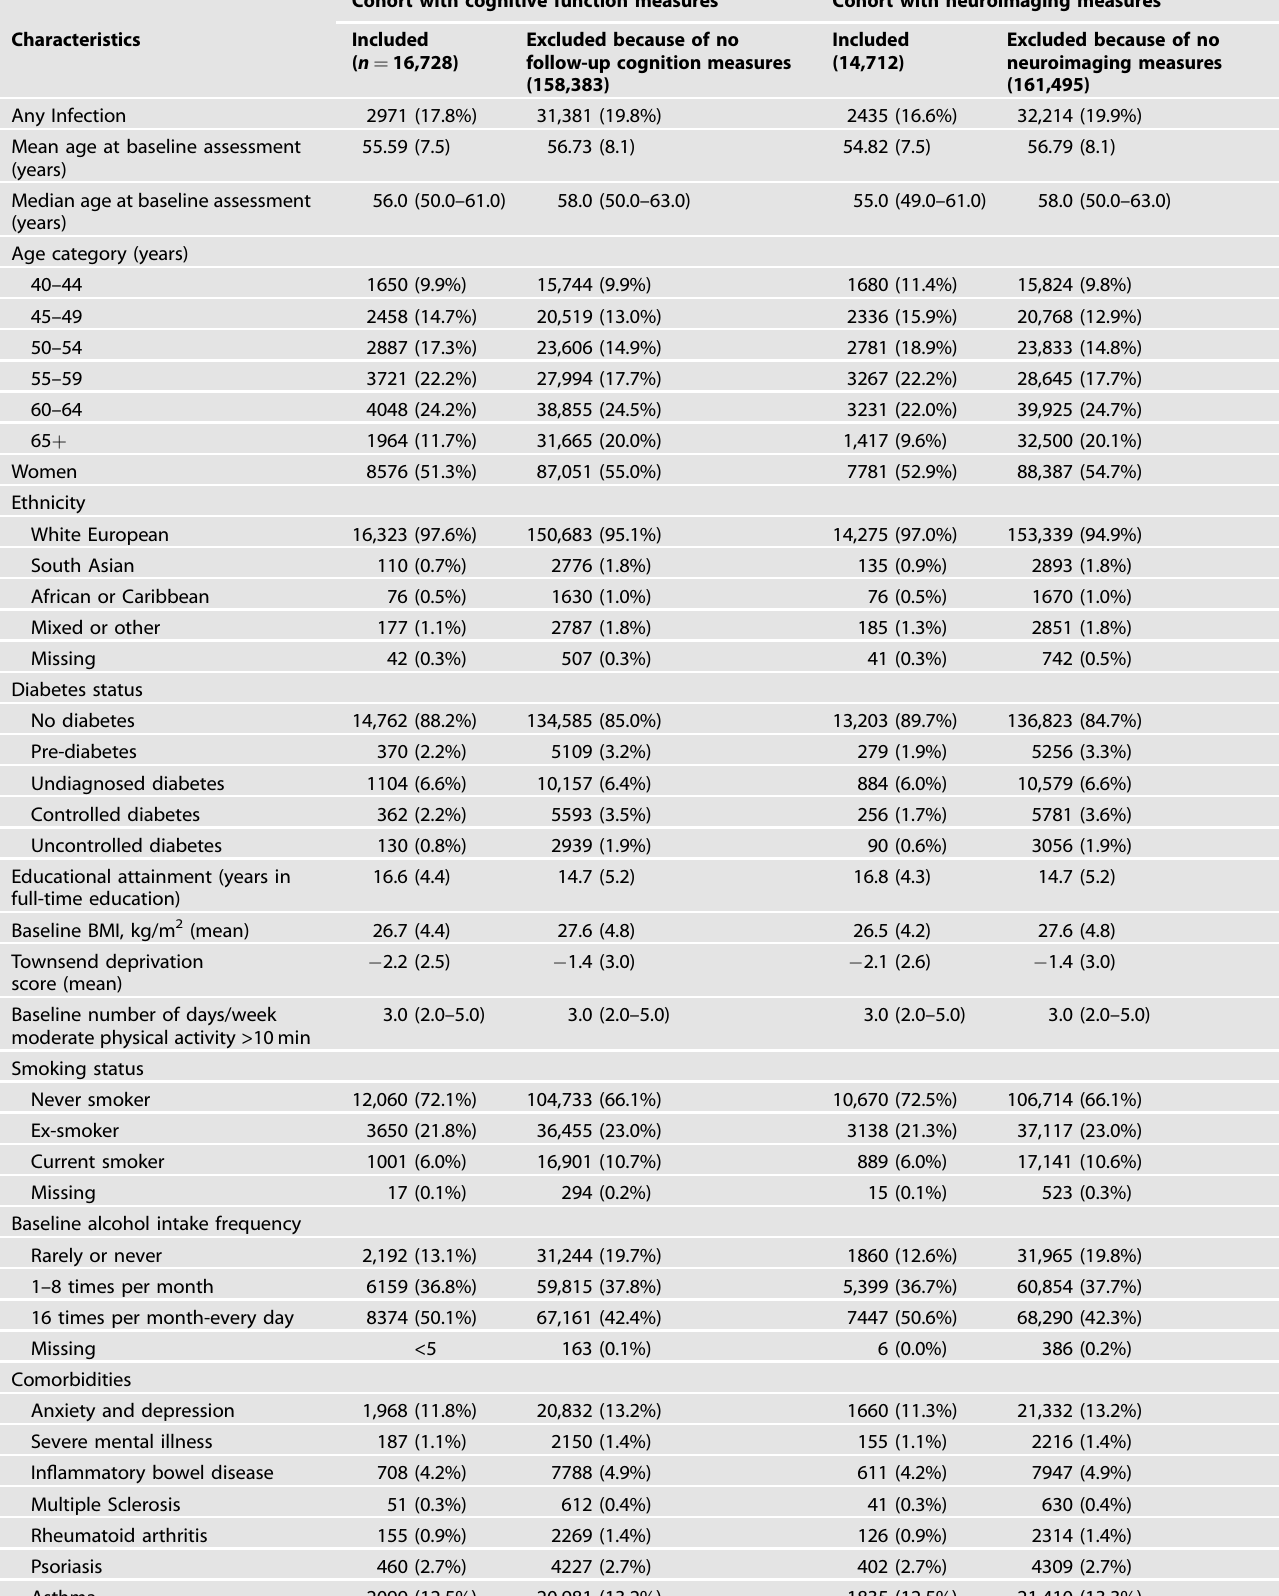
Table 1. Baseline characteristics of participants included and excluded from the study for the cognitive function and neuroimaging